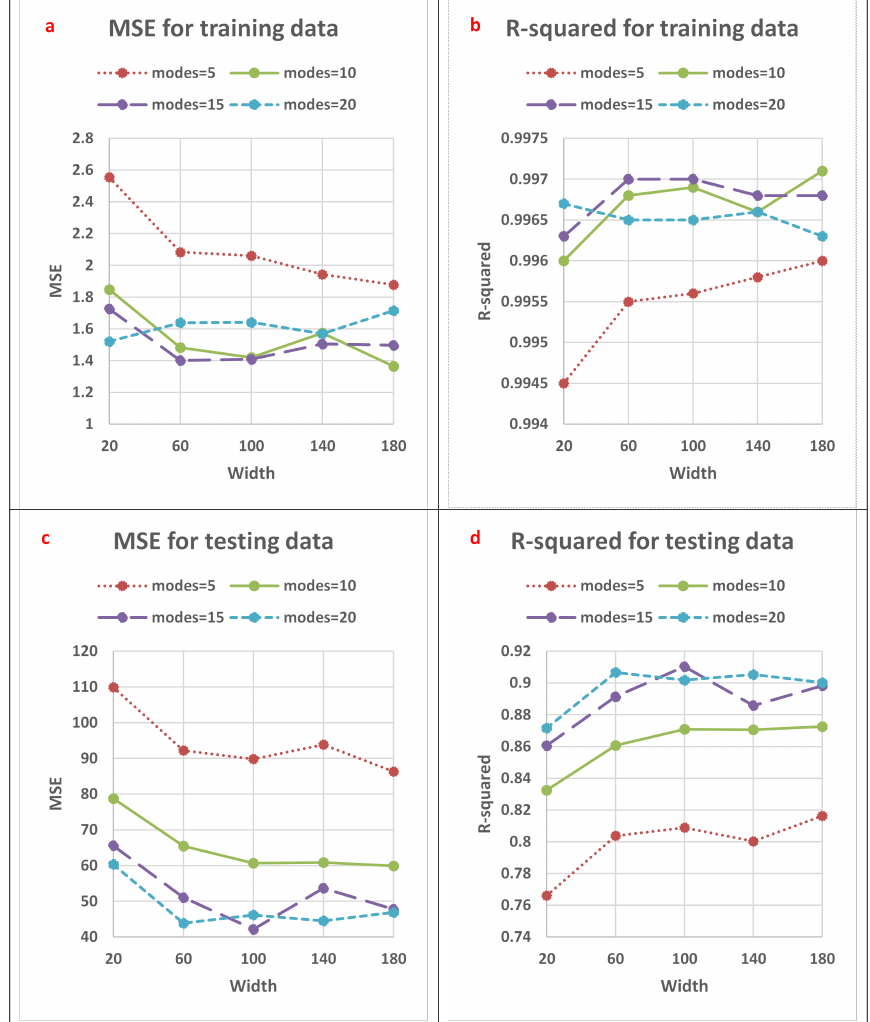
Figure 3. Prediction error graphical analysis of the developed FNO models: ( a ) MSE for training data, ( b ) R 2 for training data, ( c ) MSE for testing data, and ( d ) R 2 for testing